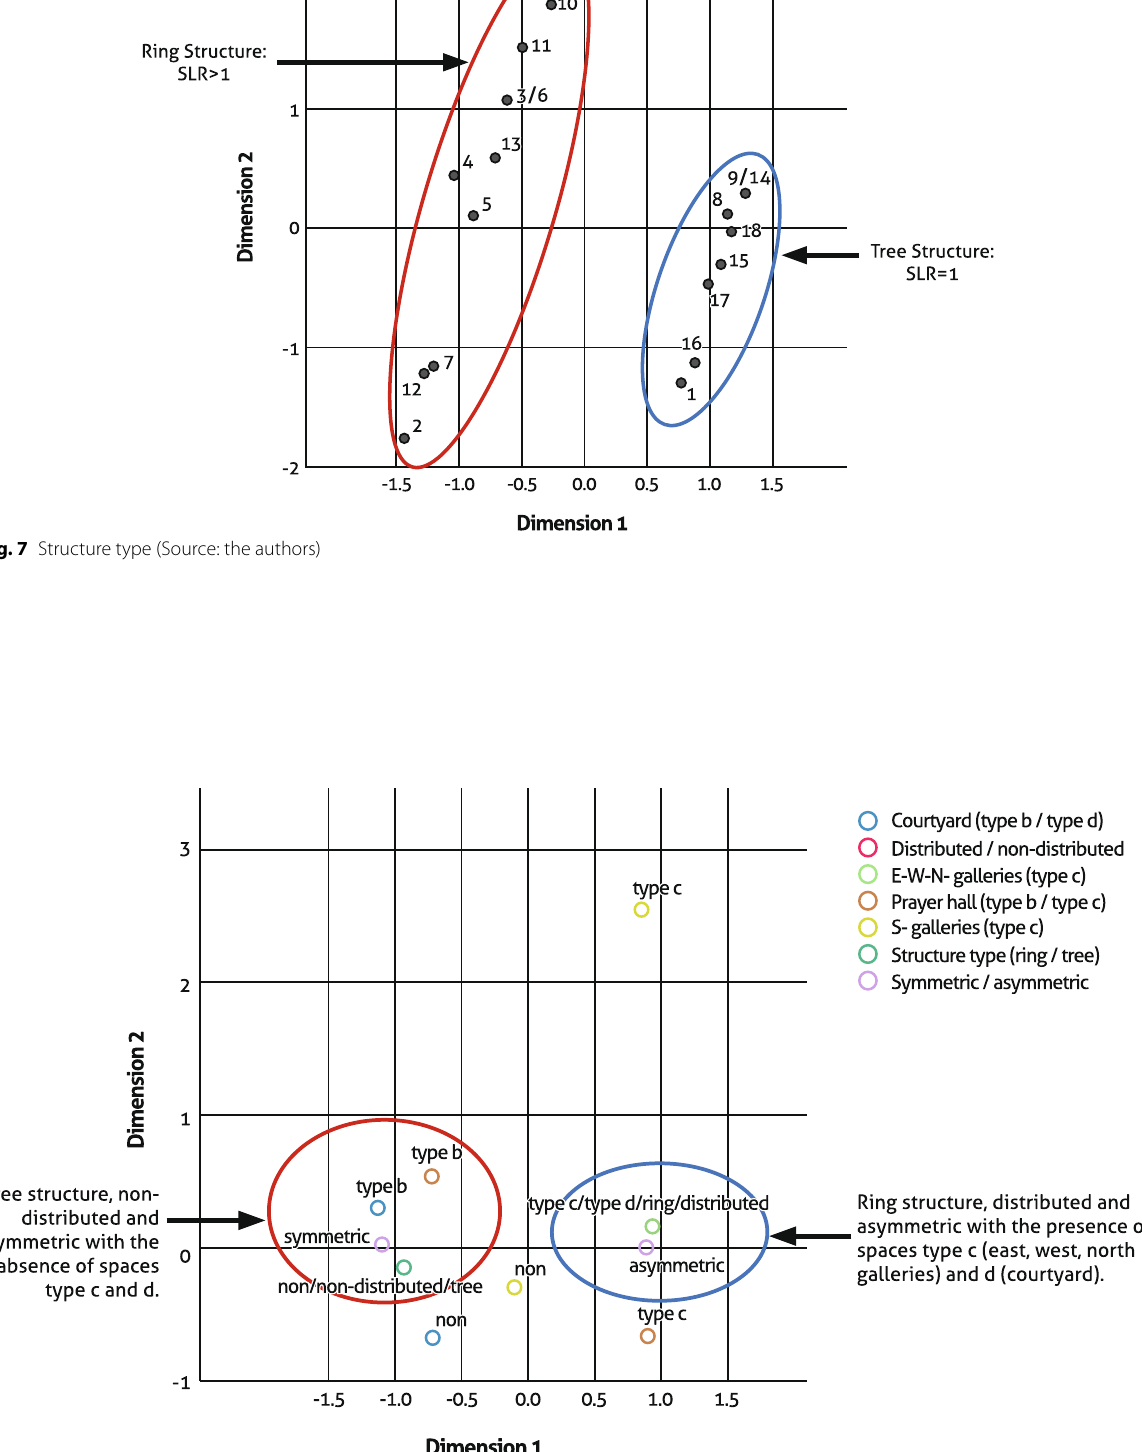
Fig. 8 Qualitative syntactic characteristics (Source: the authors)